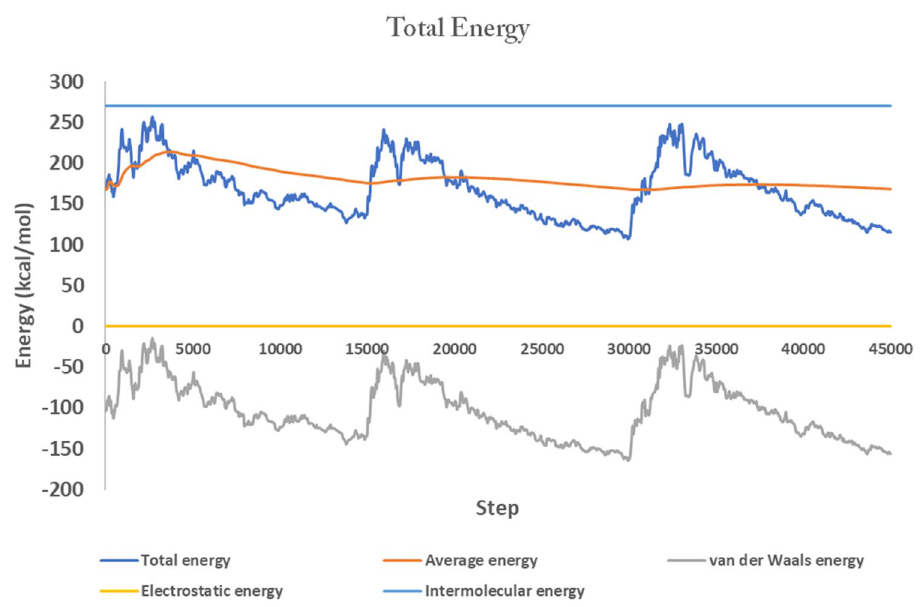
Fig. 12 The different kinds of energy involved in the adsorp- tion of NaOH on reservoir